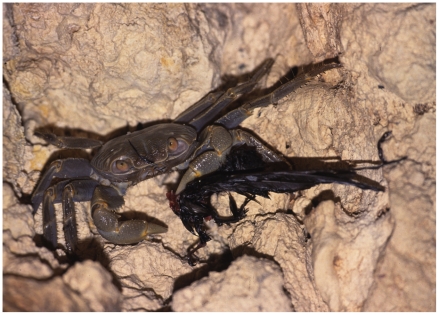

Geograpsus crinipes devouring swiftlet, Palau (photo courtesy of Mandy Etpison).